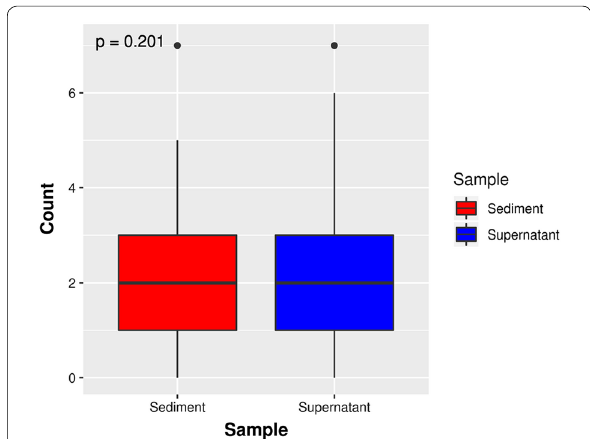
Fig. 4 Boxplot illustrating the frequency of mutations in the urine supernatant and sediments from 92 cases. The boxplot shows the number of positive mutant genes among 92 tumor patients, whose urine supernatant and sediment samples were screened using the 48-gene panel. The points in the graph represent discrete points that were statistically distant from the median. The Y-axis represents the number of mutated genes in the sample. A t-test analysis revealed that there was no statistically significant difference in the number of mutated genes between the urine supernatant and sediments obtained from the same subjects (p =